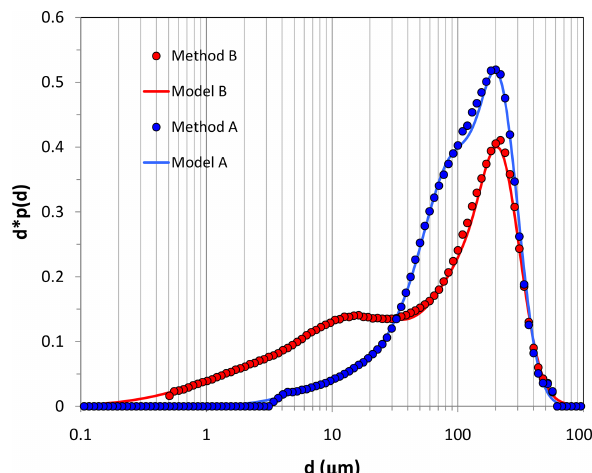
Figure 1. Soil particle-size distribution obtained using Method A and Method B, together with the respective approximations (Model A and Model